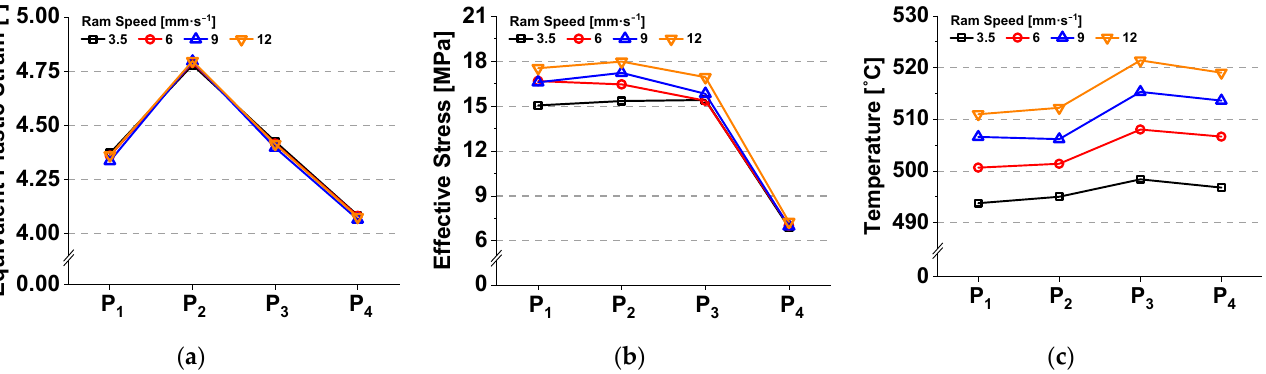
Figure 11. Influence of ram speed on the variations in physical quantities: ( a ) equivalent plastic strain; ( b ) von Mises effective stress; and ( c ) temperature.